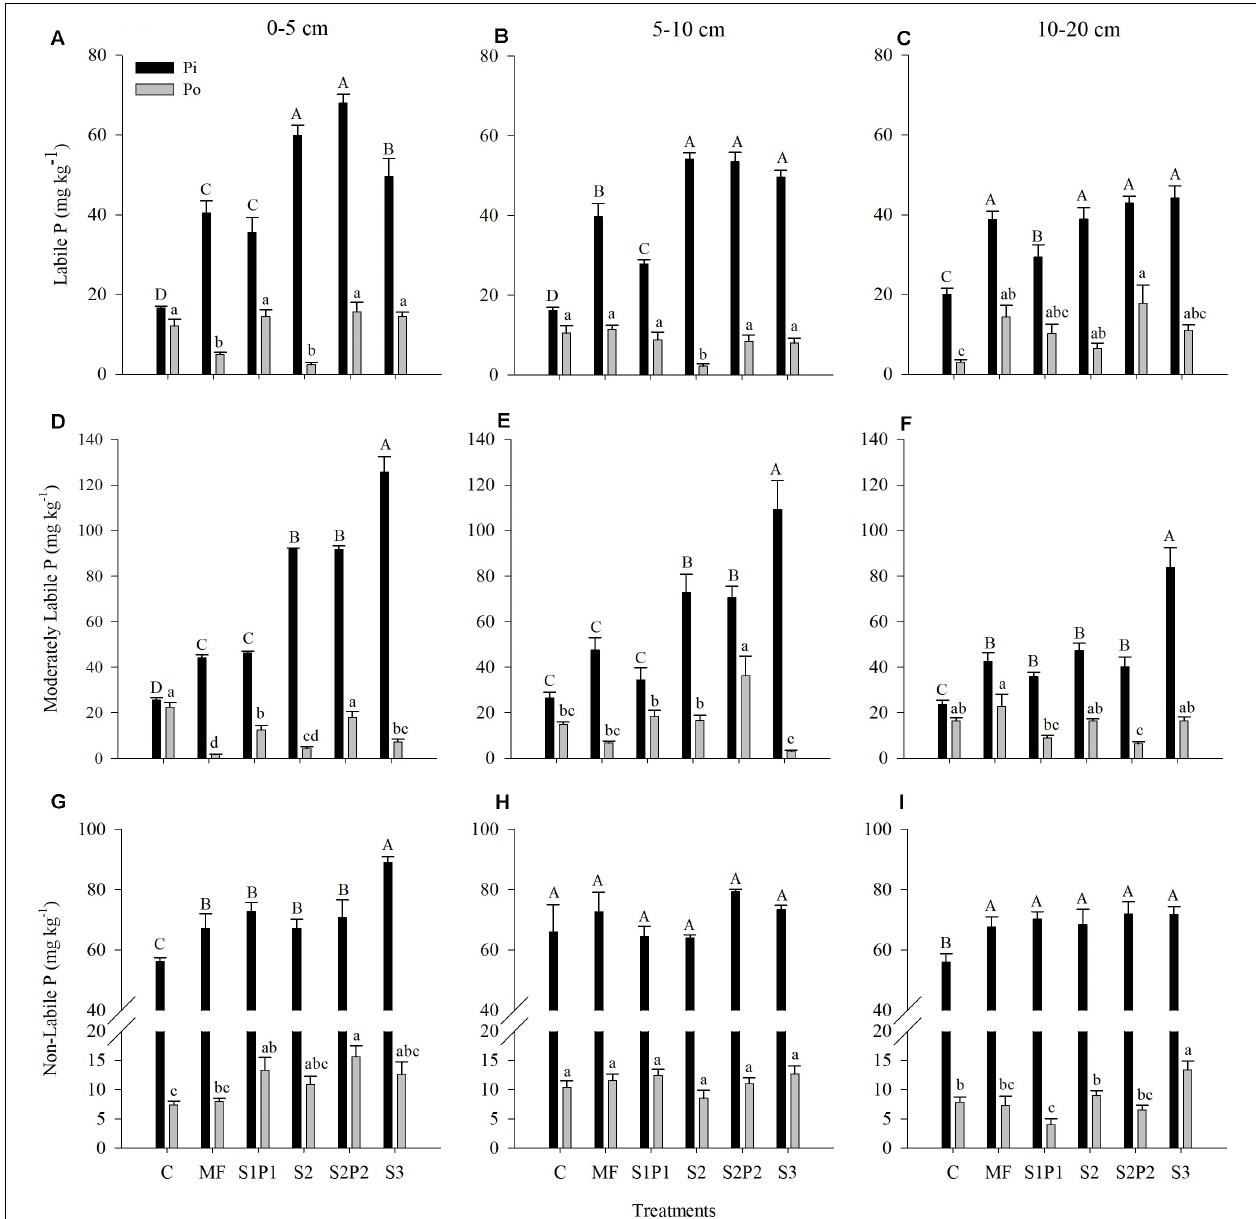
FIGURE 2 | Inorganic ( P i ) and organic ( P o ) labile (A–C) , mederately (D–F) and non-labile (G–I) phosphorus in soil, 15 months after sewage sludge application (SS was applied 7 months after E. urograndis planting). C, control; MF, mineral fertilizer; S1P1, sludge (50%) + P (83%) + B + K; S2, sludge (100%), P + B + K; S2P2, sludge (100%) + P (66%) + B + K; S3, sludge (150%) - P + B + K. Bars followed by the same letter, uppercase to P i and lowercase to P o , do not differ by the Duncan test ( p ≤ 0.05). Vertical lines on bars represent standard error ( n =